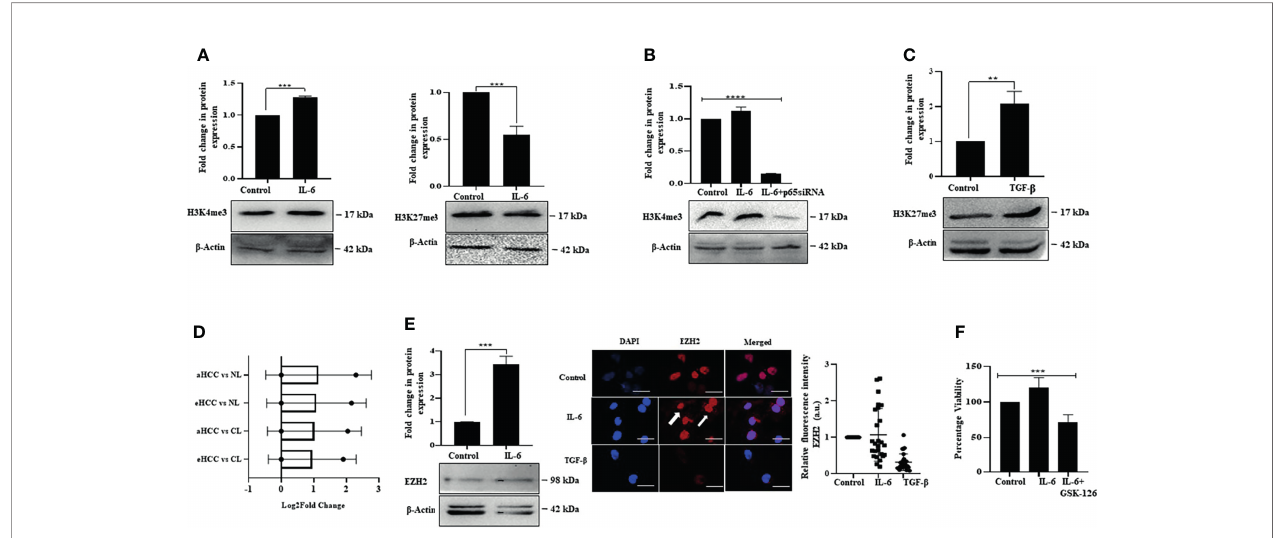
FIGURE 8 | IL-6 induces open chromatin marks while TGF- b promotes closed chromatin signature. (A) Immunoblot showing expression of H3K4me3 and H3K27me3 in IL-6-treated cells post 72 h of exposure. (B) Immunoblot showing expression of H3K4me3 in untreated or IL-6-treated or IL-6 plus p65-siRNA treated cells at 72 h. (C) Immunoblot showing expression of H3K27me3 after TGF- b treatment for 72 h. (D) EZH2 transcripts levels obtained from the GEO database for subjects with cirrhotic liver (CL), early HCC (eHCC), and advanced HCC (aHCC) compared to healthy control (normal-NL). (E) Immunoblot showing expression of EZH2 in IL-6-treated cells at 72 h; immuno fl uorescence image and relative fl uorescence intensity of EZH2 after IL-6 or TGF- b treatment (scale bar: 10 m m). The white arrow indicates EZH2 protein. (F) Cell viability analysis after IL-6 or IL-6 plus GSK-126 (50 µM) treatment for 72 h. **, *** and **** refers to p value signi fi cance of ≤ 0.01, ≤ 0.001 & ≤ 0.0001